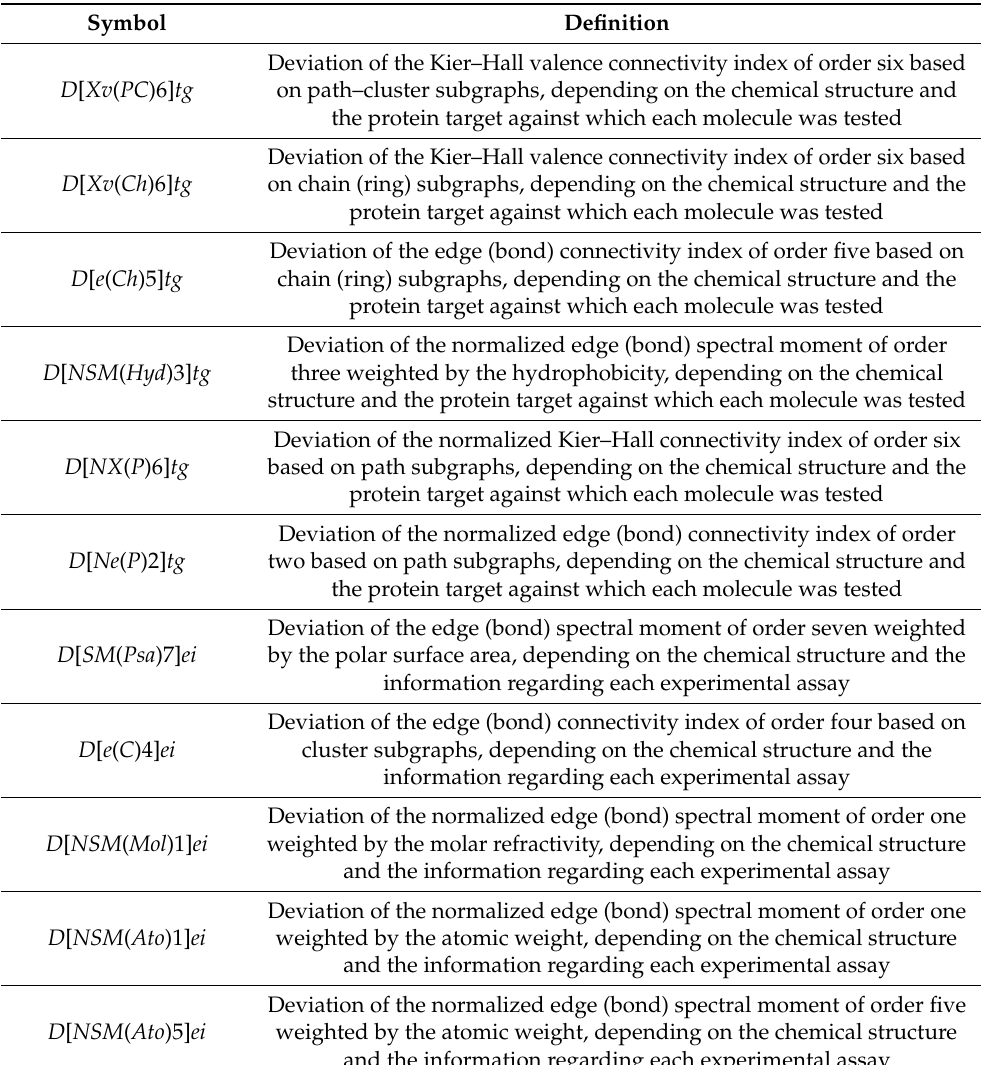
Table 2. Symbols and definitions of the D [ GTI ] cj descriptors used to build the mtc-QSAR-MLP